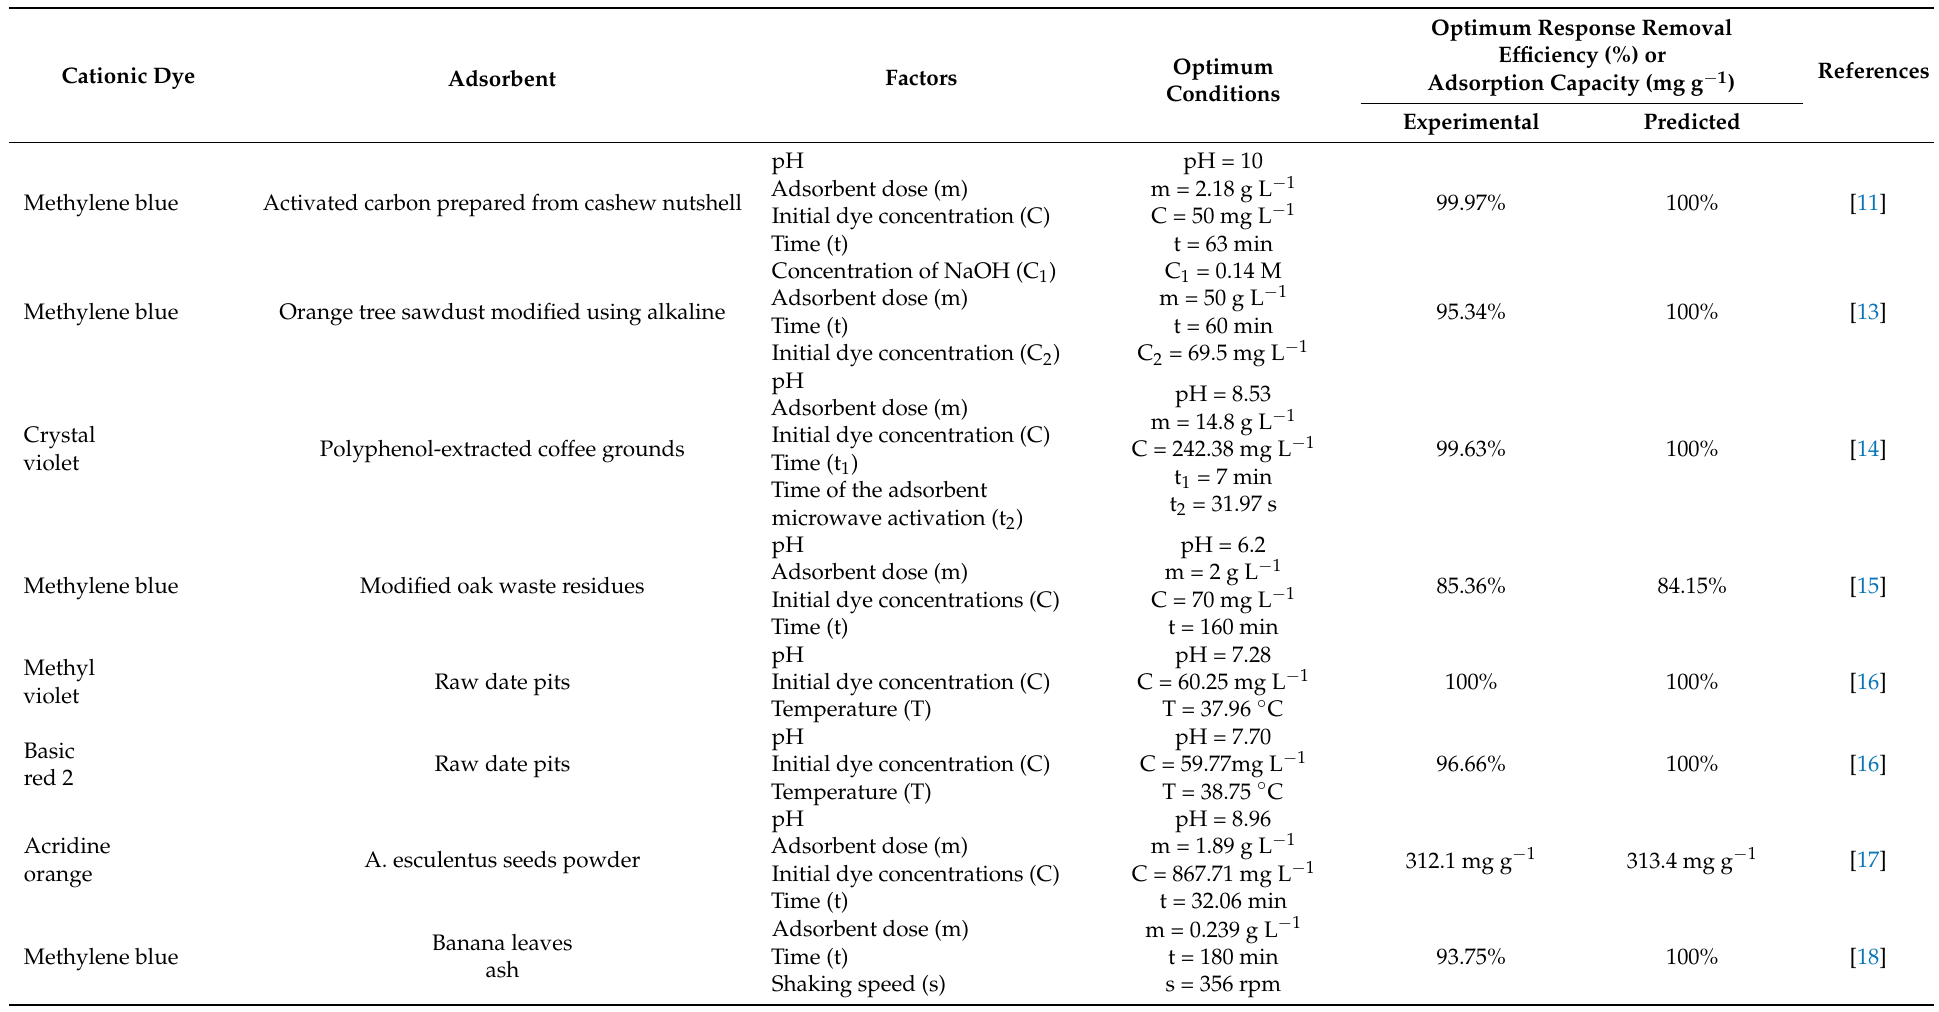
Table 1. RSM-CCD modeling in the adsorption removal of cationic